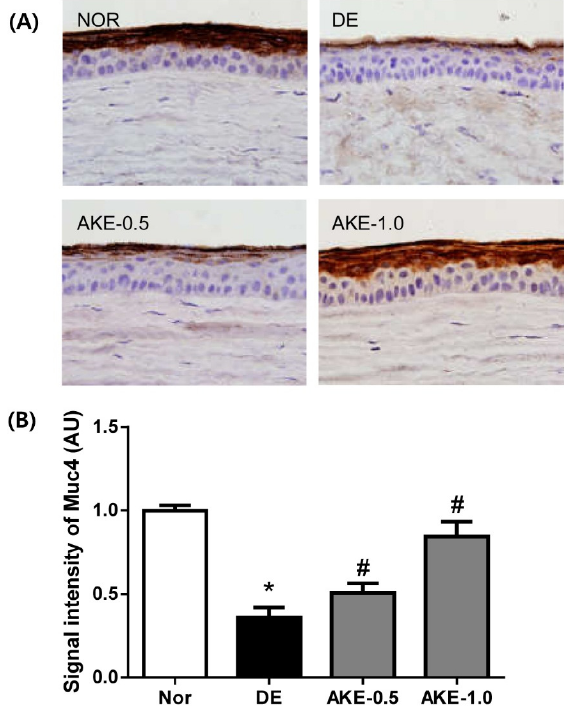
Figure 5. Effects of AKE on the expression level of Muc4 on the ocular surface. ( A ) Immunohistochemical staining for Muc4; ( B ) Morphometric analysis of the Muc4 ‐ positive signal density in corneal sections from each group. The values in the bar graph represent the mean ± SE, n = 10. * p < 0.05 vs. normal mice, # p < 0.05 vs. vehicle ‐ treated dry eye mice.